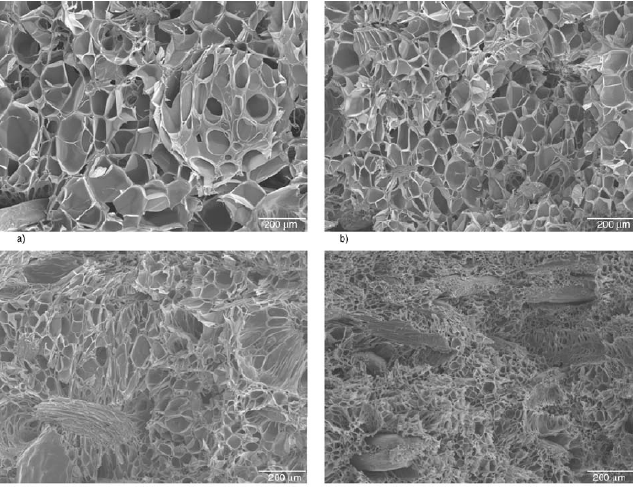
Figure 4. Effect of wood fiber content on the cellular structures of PLA: ( a ) 10 wt%, ( b ) 20 wt%, ( c ) 30 wt%, and ( d ) 40 wt%, saturation pressure 2.76 MPa for 4 days, magnification (100×). Reprinted from Matuana and Faruk with permission from Express Polymer Letters [123].